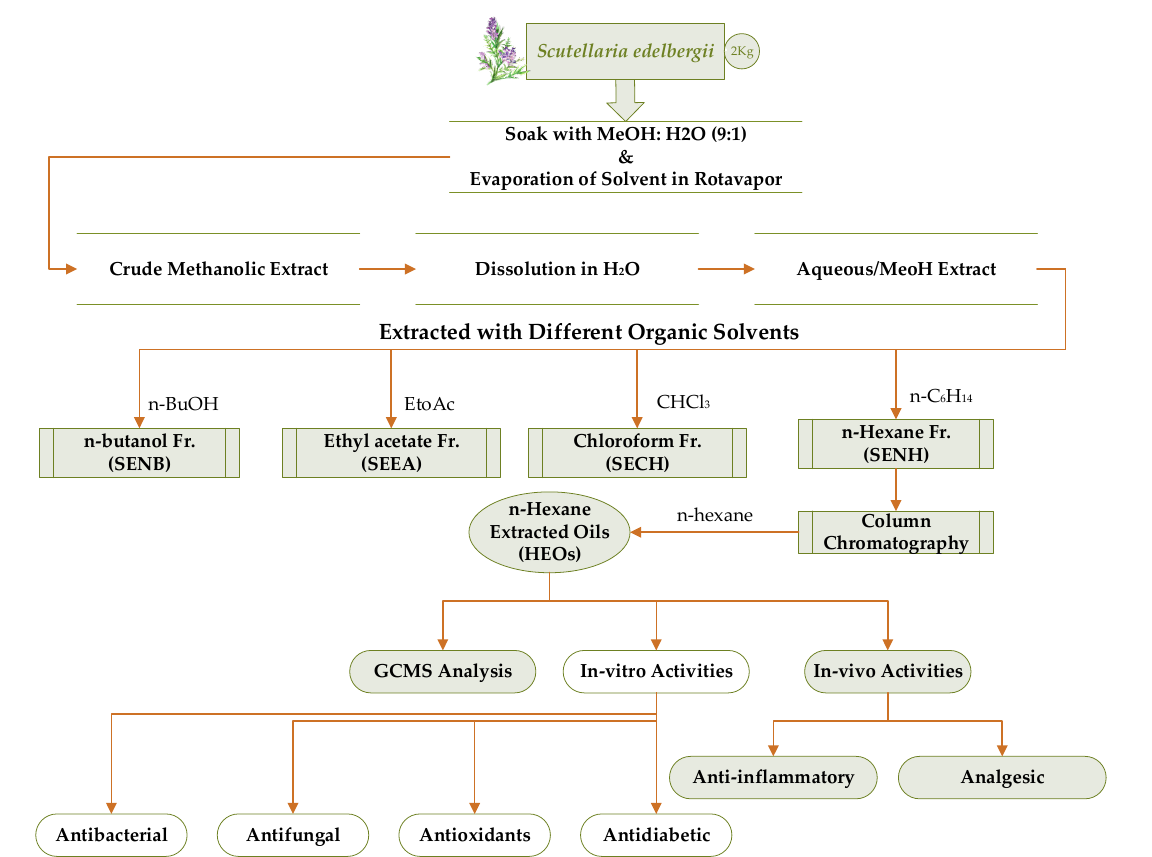
Figure 13. Schematic representation of the current study (soaking, extraction, fractionation identification, in vitro, and in vivo activities of oil). SENH = S. edelbergii n-hexane, SECH = S. edelbergii chloroform, SEEA = S. edelbergii ethyl acetate, SENB = S. edelbergii n-butanol, SEAQ = S. edelbergii aqueous fraction.